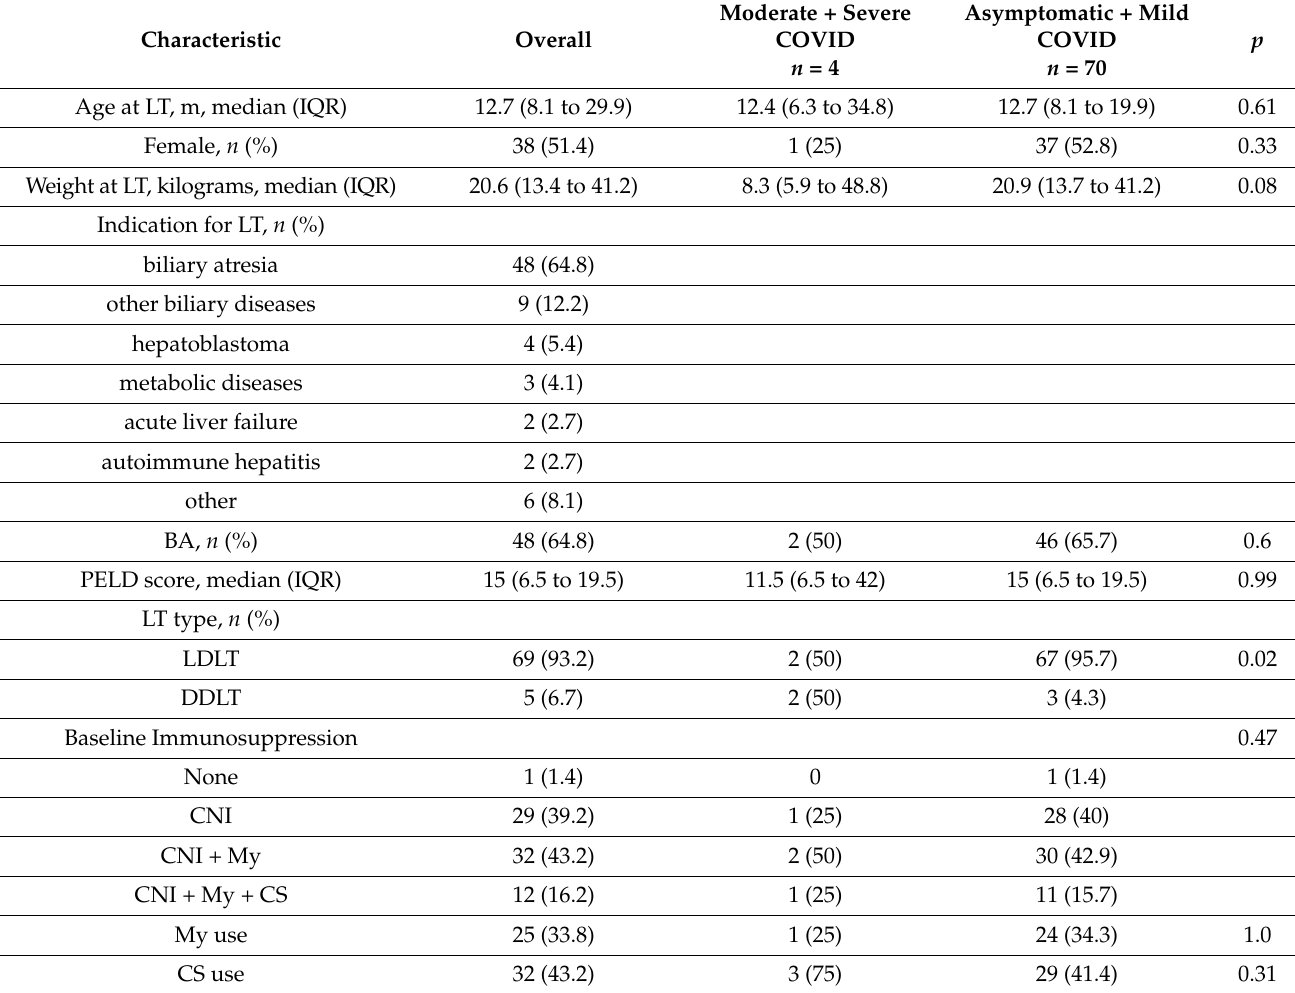
Table 1. Clinical characteristics of severity from 74 PLTR with COVID-19 infection. LT-related